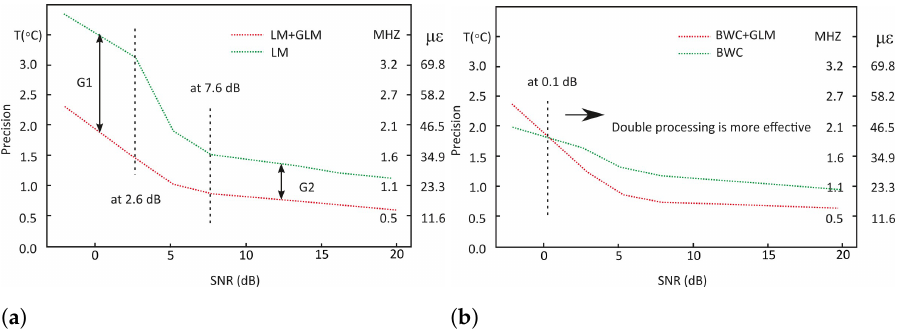
Figure 8. Measurement precision demonstrated by studied methods: ( a ) LM; ( b )